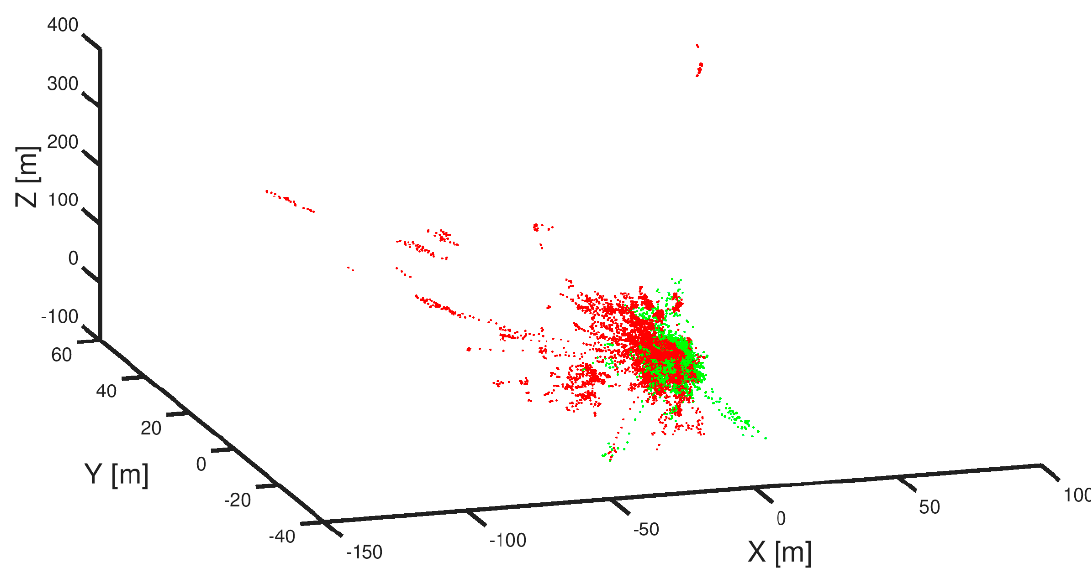
Figure 8. Overlaid results of both LSQ and new combinatorial methods for static records in urbanized aresa (green for proposed method, red for LSQ).